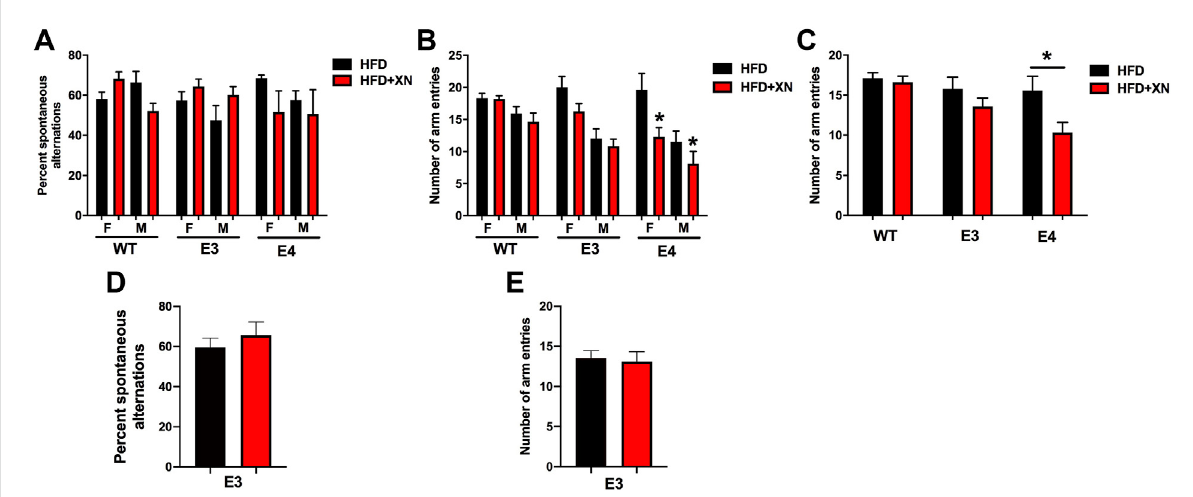
FIGURE 2 Genotype-dependent effects of XN on spontaneous alterations and activity in the Y-maze. (A) . Hippocampus-dependent spontaneous alternation in the standard exposure experiment. (B) . The number of arm entries in the Y-maze in the standard exposure experiment. In E4 mice, therewasaneffectofXNonactivitylevels.XN-treatedE4miceenteredlessarmsthansex-matchedE4miceonlyonaHFD.OveralleffectofXN:* p = 0.0004. (C) . The number of arm entries in the Y-maze with sexes combined. XN-treated E4 mice entered less arms than sex-matched E4 mice only on a HFD. * p = 0.0004. (D) . The percent of spontaneous alternations of E3 mice in the Y-maze with sexes combined in the extended exposure experiment. There was no effect of XN on spontaneous alternation of E3 mice in the extended exposure experiment. (E) . The number of arm